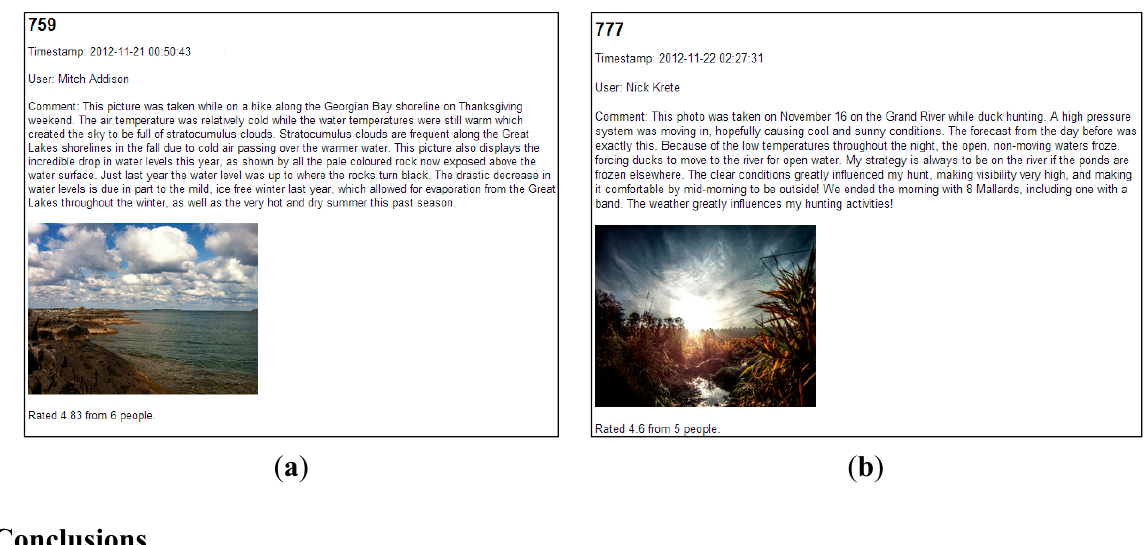
Figure 7. The winning entries in a third year Climatology course based on ( a ) jury voting and ( b ) as judged by the